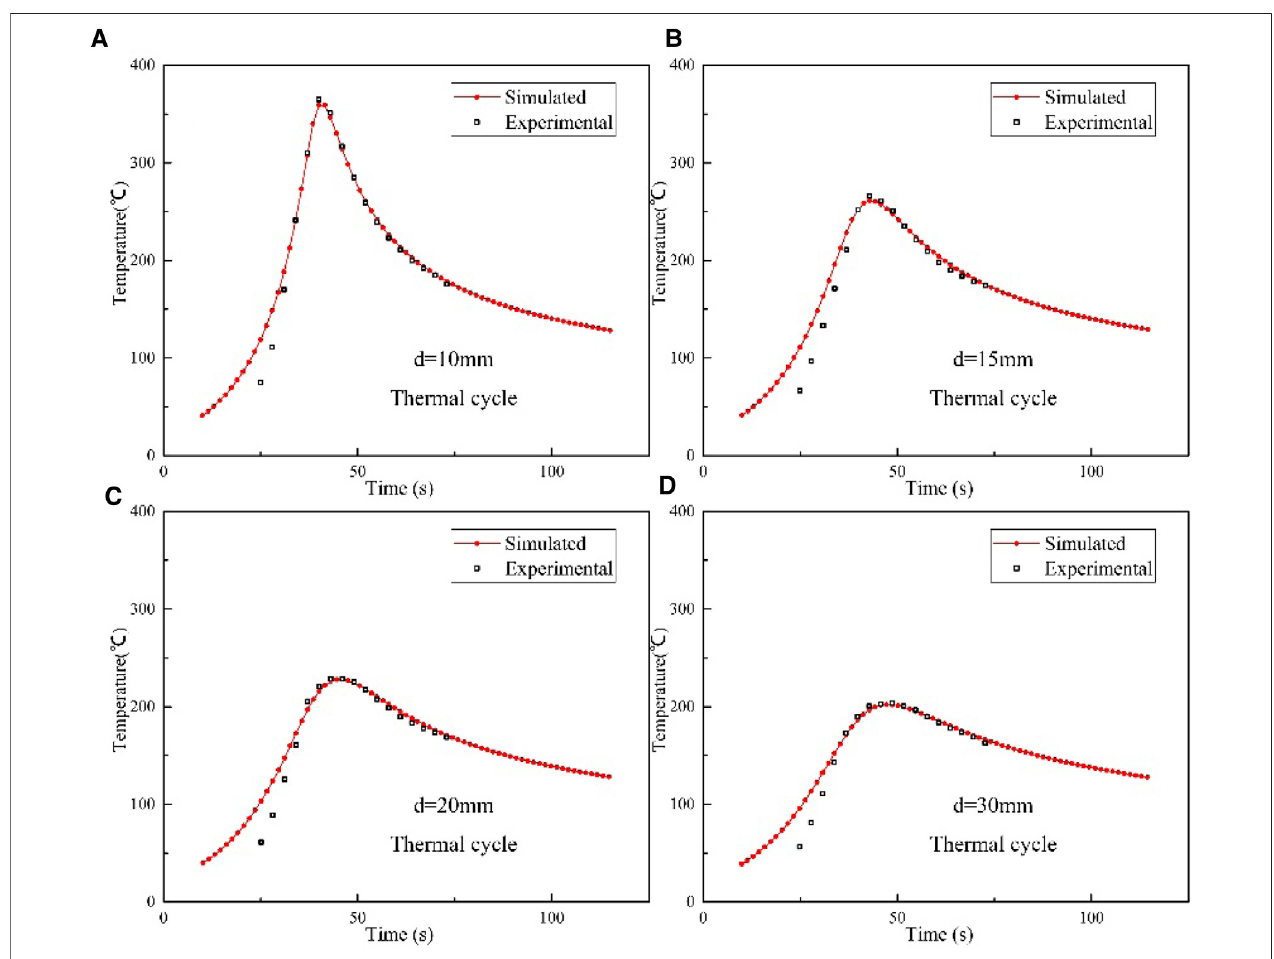
FIGURE 14 | Comparison of simulated thermal cycle curves and experimental results, (A) d (cid:1) 10 mm, (B) d (cid:1) 15 mm, (C) d (cid:1) 20 mm, (D) d (cid:1) 30 mm.